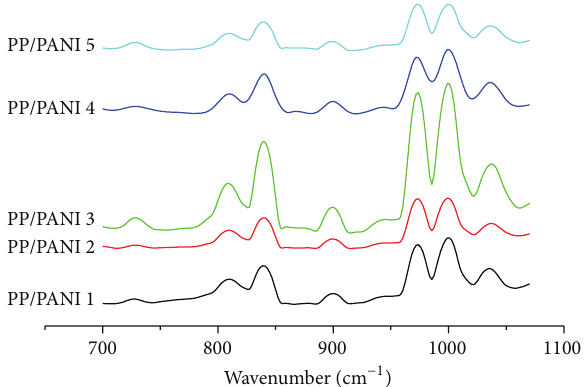
Figure 3: FTIR spectra of the PP/CPP/PANI composites.